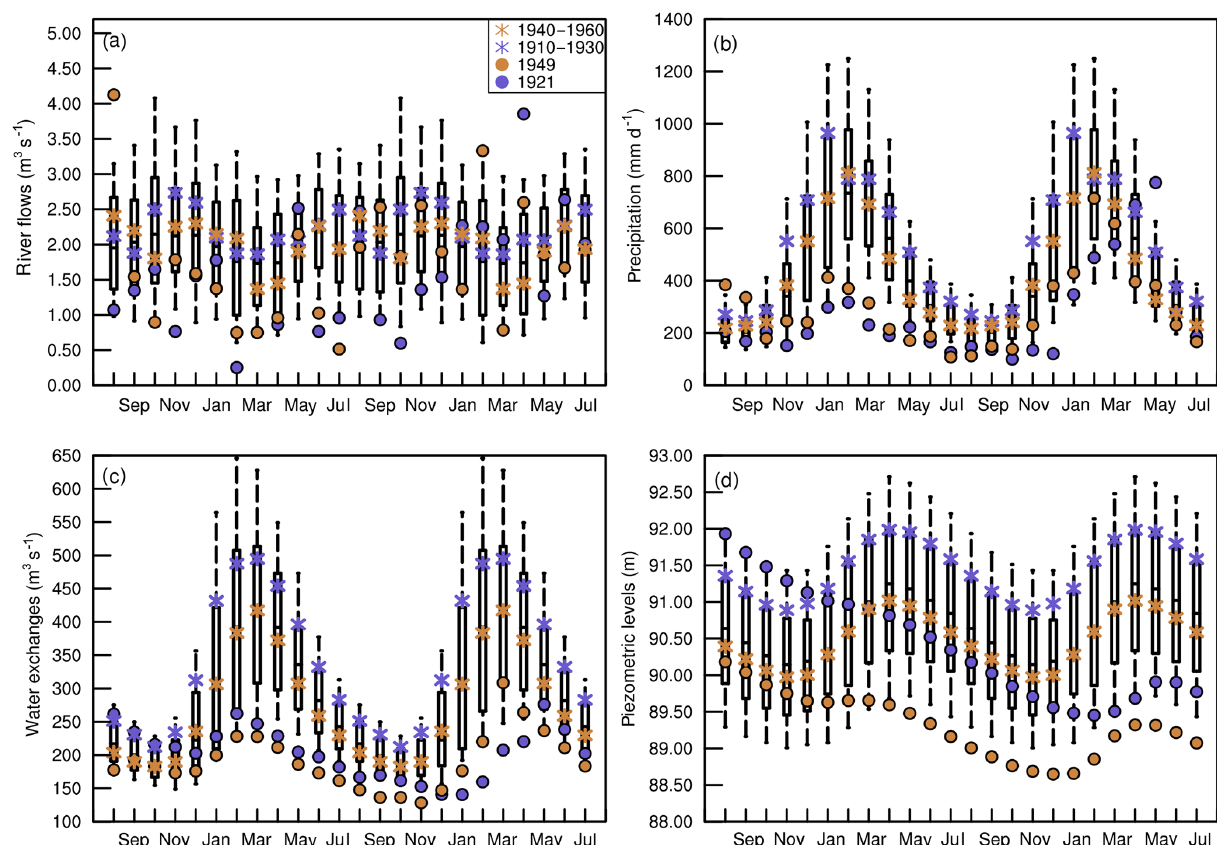
Figure 14. (a) Evolution of monthly precipitation (mmd − 1 ) averaged over the Seine basin from August 1920 to July 1922 (purple dots) and from August 1948 to July 1950 (beige dots). The boxplots represent the climatological monthly distributions calculated over the period 1852–2008. Purple (beige) crosses show the monthly average over the period 1910–1930 (1940–1960). (b) Same as panel (a) for river flows at Poses (m 3 s − 1 ), (c) water exchanges between groundwater and rivers (m 3 s − 1 ) and (d) the piezometric levels (m) of the unconfined part of the aquifer. The data come from the Seine reconstruction. The boxplots are defined with the 10th percentile, 25th percentile, median, 75th percentile and 90th